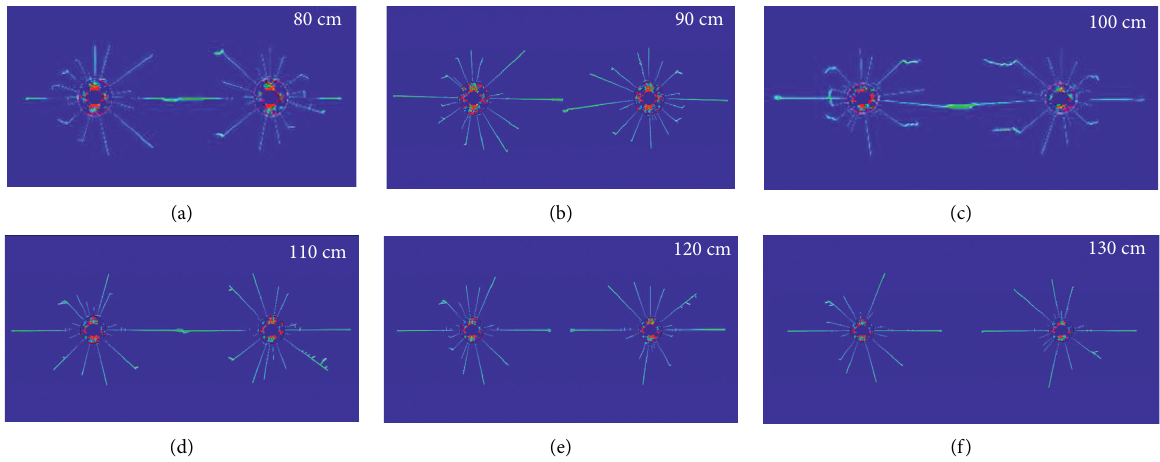
Figure 18: Damage evolution diagram under different borehole spacing.